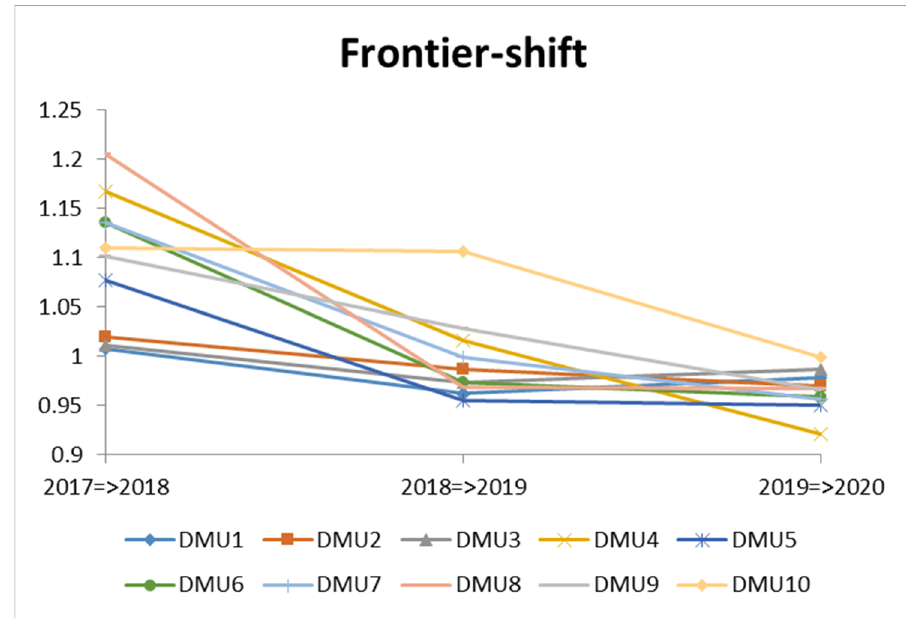
Figure 6. Technological change (frontier-shift) of DMUs (2017–2020).